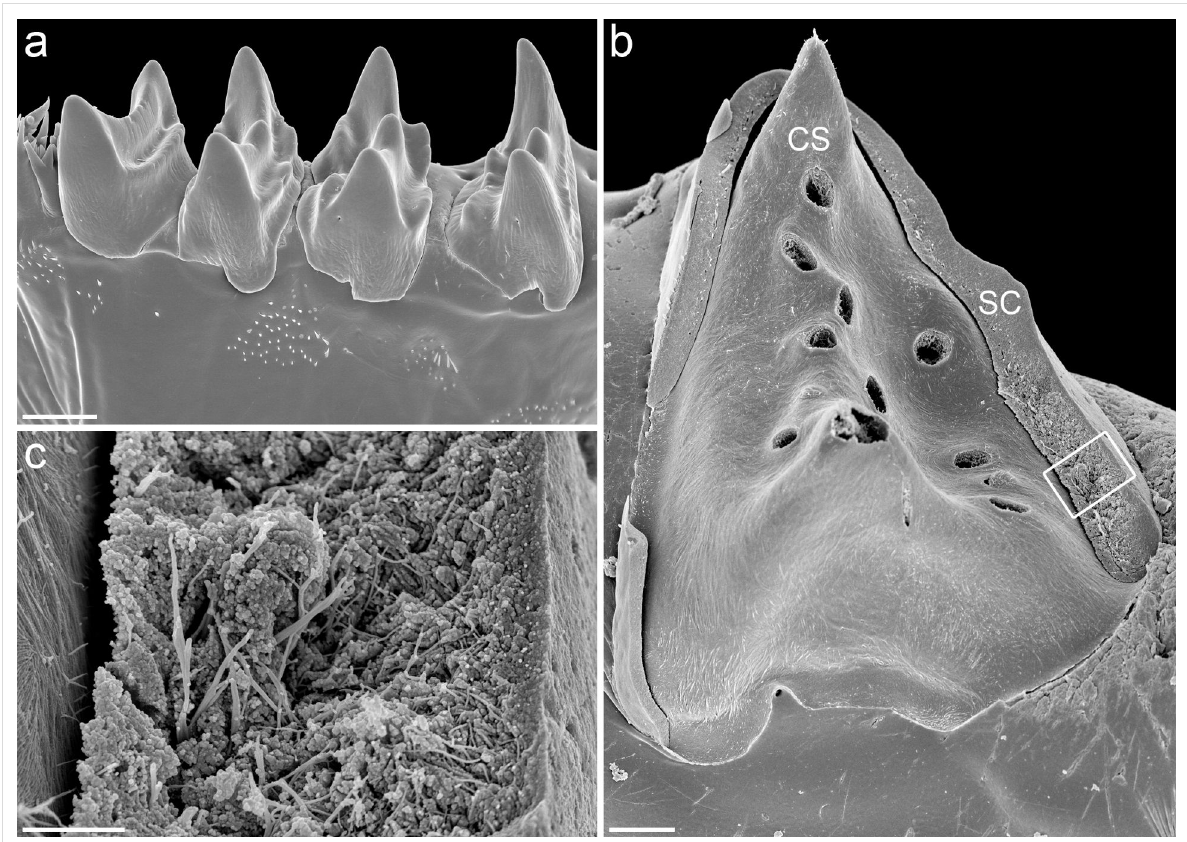
Figure 6: Mandibular gnathobases of female Rhincalanus gigas . Scanning electron micrographs (all caudal view). (a) The four central teeth. (b) Central tooth after the removal of large parts of the silica-containing cap-like structure. (c) Detailed view of the structures marked by the rectan- gular frame in (b). Scale bars = 20 µm (a), 5 µm (b), 1 µm (c). CS = chitinous socket, SC = silica-containing cap-like structure. Figure adapted with permission from [33]. Copyright 2015 Elsevier.